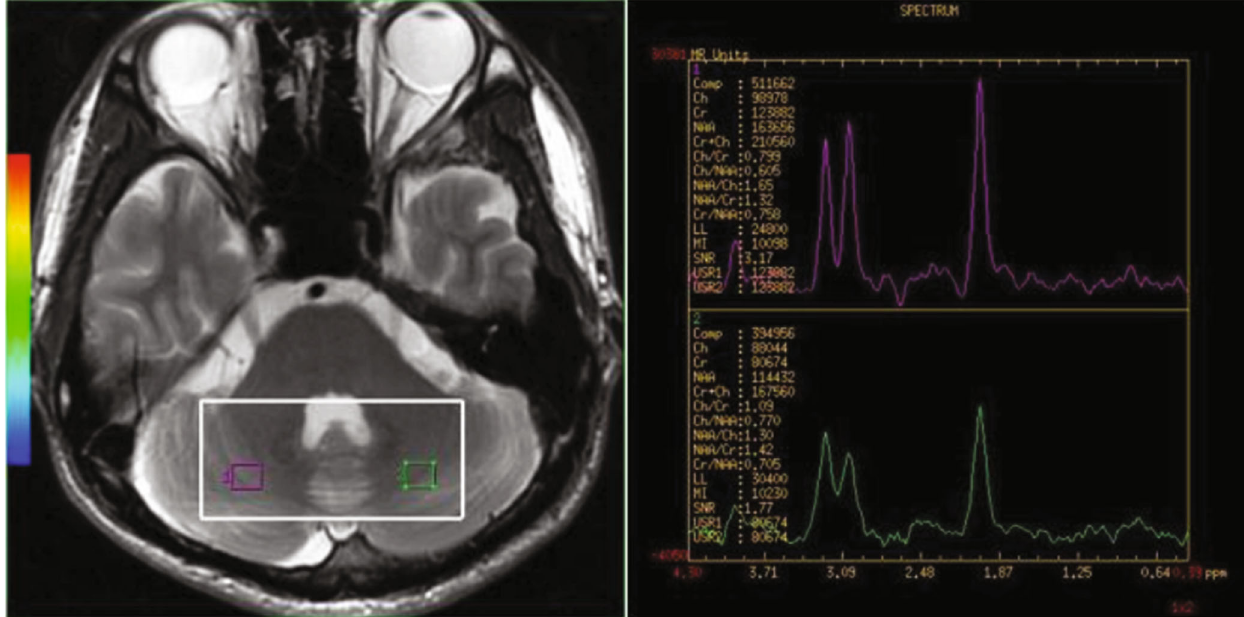
Figure 2: MRI showing the location of MRS of the VOI placed in the cerebellum, with 1 H-MRS in the bilateral cerebellum. The large white box shows the VOIx for MRS acquisition, and the small ones depict individual VOIs for spectral analysis. MRI: magnetic resonance imaging; MRS: magnetic resonance spectroscopy; VOI: volume of interest; 1 H-MRS: proton magnetic resonance spectroscopy; NAA: N- acetylaspartate; Cho: choline; Cr: